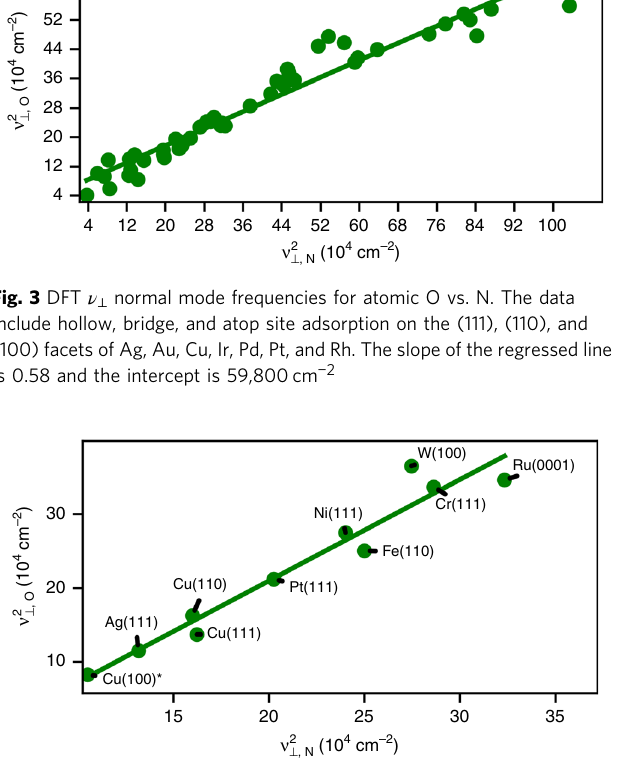
Fig. 4 Experimental ν ⊥ frequencies for atomic O vs. N. Label Cu(100)* indicates ordered adsorbate layers at high coverage. Atomic O adsorption is typically at low coverage. Atomic N was often co-adsorbed with other species. The slope of the regressed line is 1.37 and the intercept is − 64,500 cm −